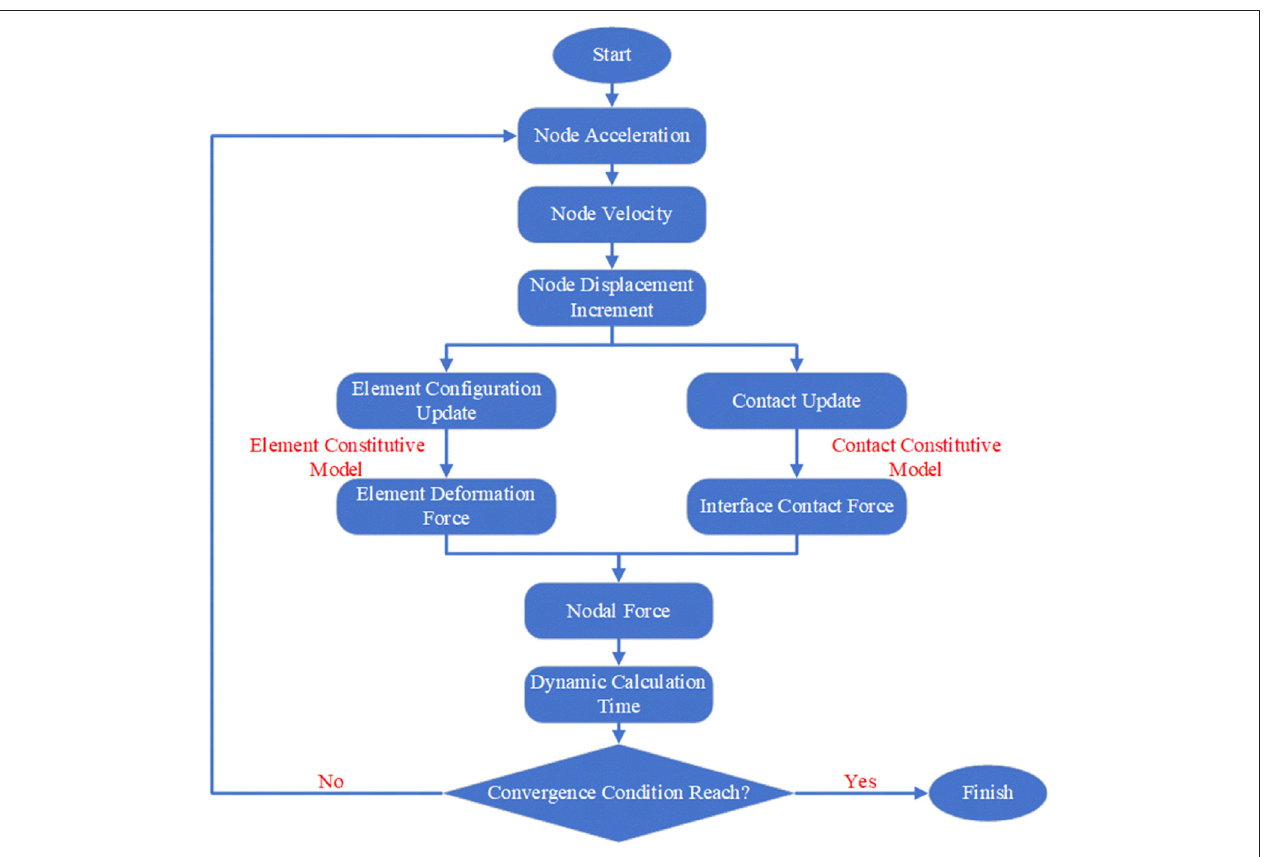
FIGURE 4 | Flowchart of the iteration process in